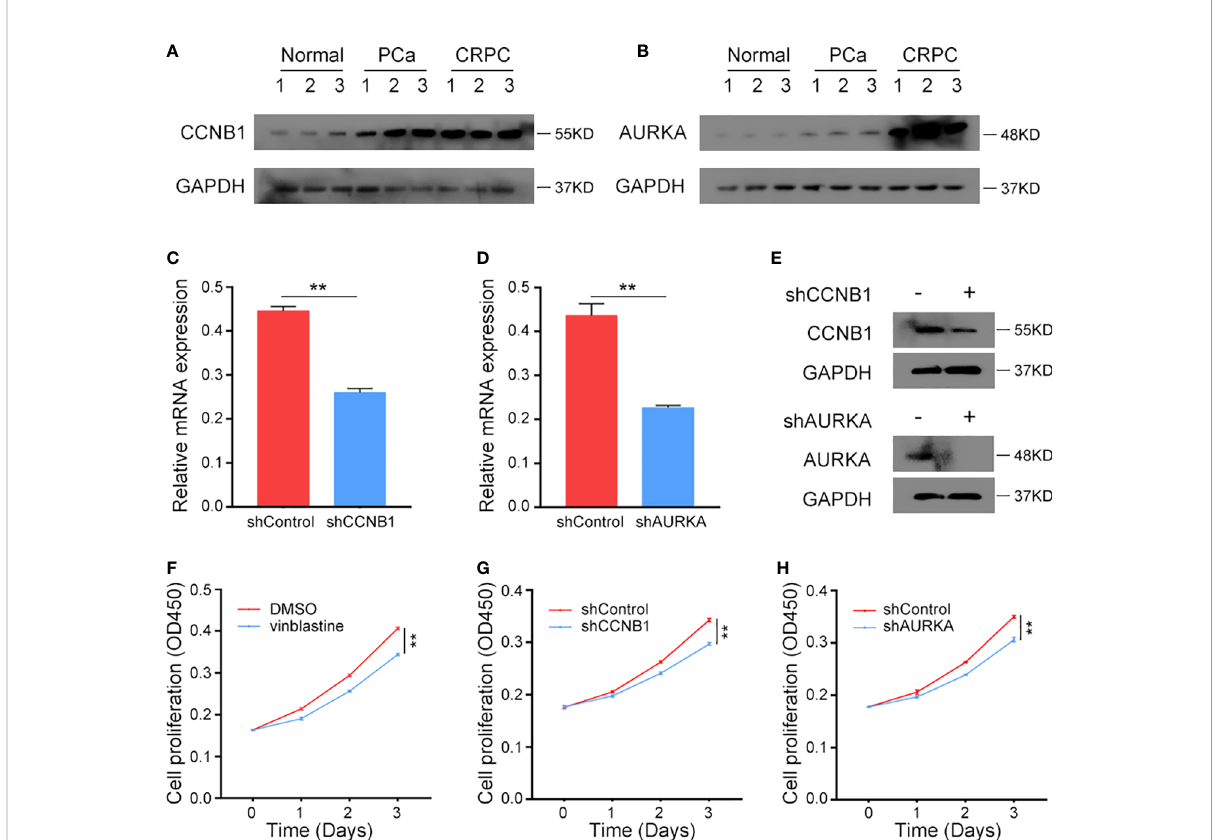
FIGURE 8 The expression CCNB1 and AURKA in clinical samples and the function of CCNB1 and AURKA to C4-2 cells in vinblastine. (A, B) The protein level of CCNB1 (A) and AURKA (B) in normal, primary PCa, and CRPC samples. (C, D) The mRNA level of CCNB1 (C) and AURKA (D) when different lentivirus transfected into C4-2 CRPC cells. (E) The protein level of CCNB1 and AURKA when different lentivirus transfected into C4-2 CRPC cells. (F) The cell proliferation level of C4-2 cells when C4-2 cells treated by DMSO or vinblastine. (G, H) The cell proliferation level of C4-2 cells after different lentivirus transfected into C4-2 CRPC cells with vinblastine treatment. (G) shCCNB1 (H) shAURKA. ** represents P